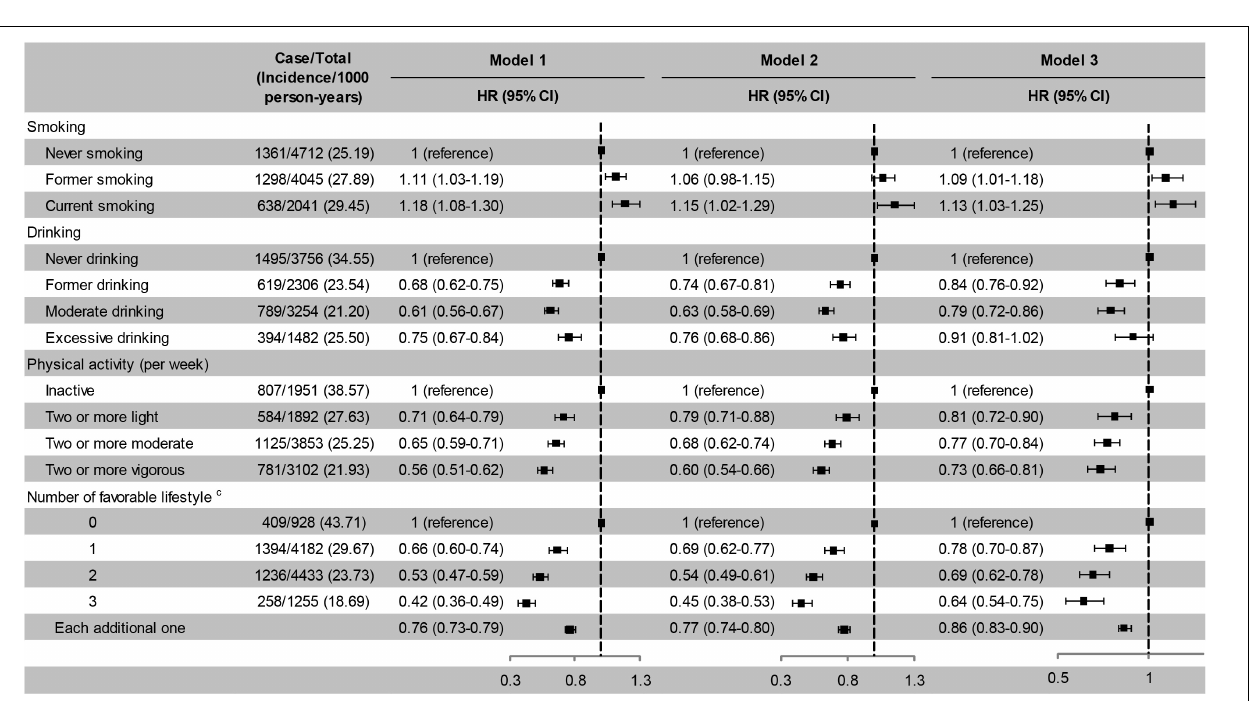
FIGURE 2 | Risk of cognitive impairment according to body weight status and PRS for BMI. Model 1, unadjusted; Model 2, adjusted for baseline age and sex; Model 3, adjusted for smoking, drinking, physical activity, baseline age, sex, education, marital status, and family wealth per capita. a PRS for BMI was also adjusted in model 3; b Five principal components and body weight status were also adjusted in model 3. (cid:78) Not significant; (cid:7) Significant. PRS, polygenic risk score; BMI, body mass index; HR, hazard ratio; CI, confidence interval; SD, standard deviation. The significance level was set at α = 0.025 (0.05/2).